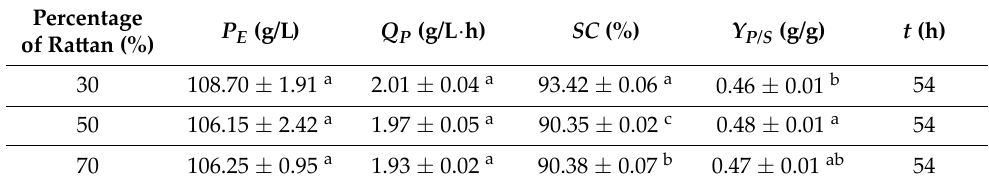
P E = ethanol concentration, Q P = ethanol productivity, SC = sugar consumption (%), Y P / S = ethanol yield (g/g), and t = fermentation time (h). a , b , c , ab Means having the same letter within the same column are not significantly different when using Duncan’s multiple range test at a p -level < 0.05. The results are expressed as the mean ± SD of triplicate experiments.